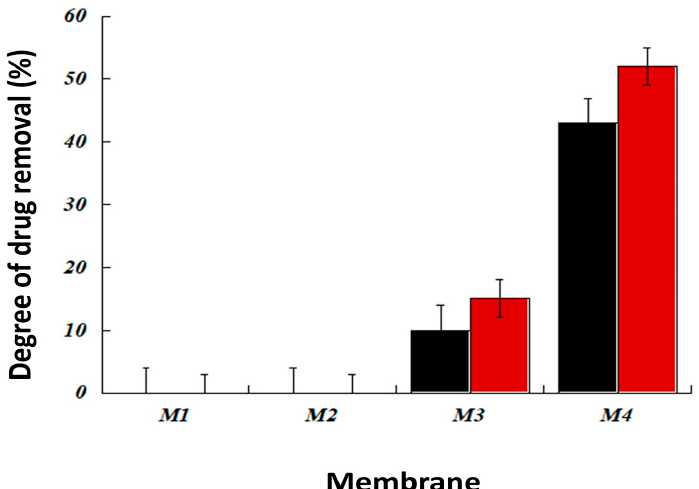
Figure 7. Influence of membrane composition on extraction of residual drug in wastewater. Different membranes were tested: PVC (M1), PVC/DBP (M2), PVC/poly( β -cyclodextrin) (M3) and PVC/DBP/poly( β -cyclodextrin) (M4). Two drugs were tested at an initial concentration of 10 ppm: ibuprofen (red circles) and progesterone (black squares). The extraction process was performed over 6 h. Each essay was performed in triplicate.